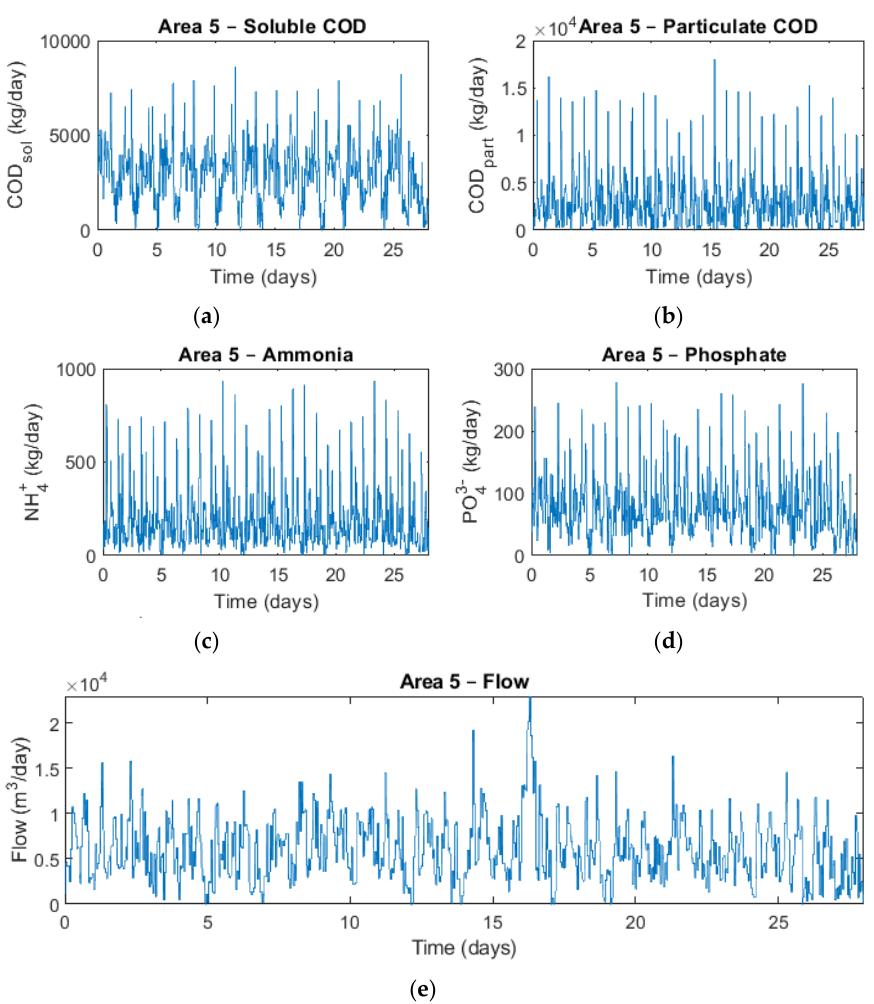
Figure 3. The influent corresponding to the 5th collection area: ( a ) soluble COD; ( b ) particulate COD; ( c ) ammonia; ( d ) phosphate; ( e ) flow of the 5th collection area.